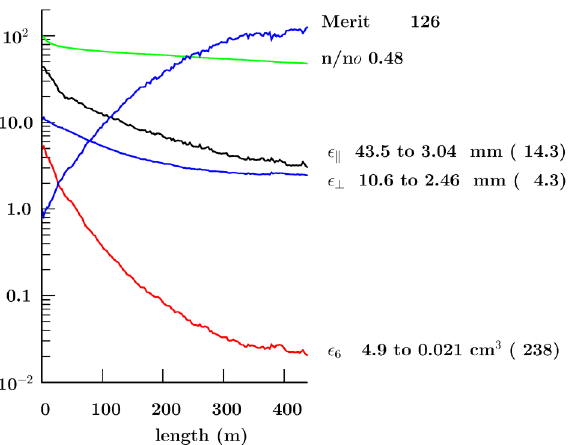
FIG. 39. (Color) Transmission, normalized transverse emittance, normalized longitudinal emittance, normalized 6-dimensional emittance, and the merit factor, as a function of distance.